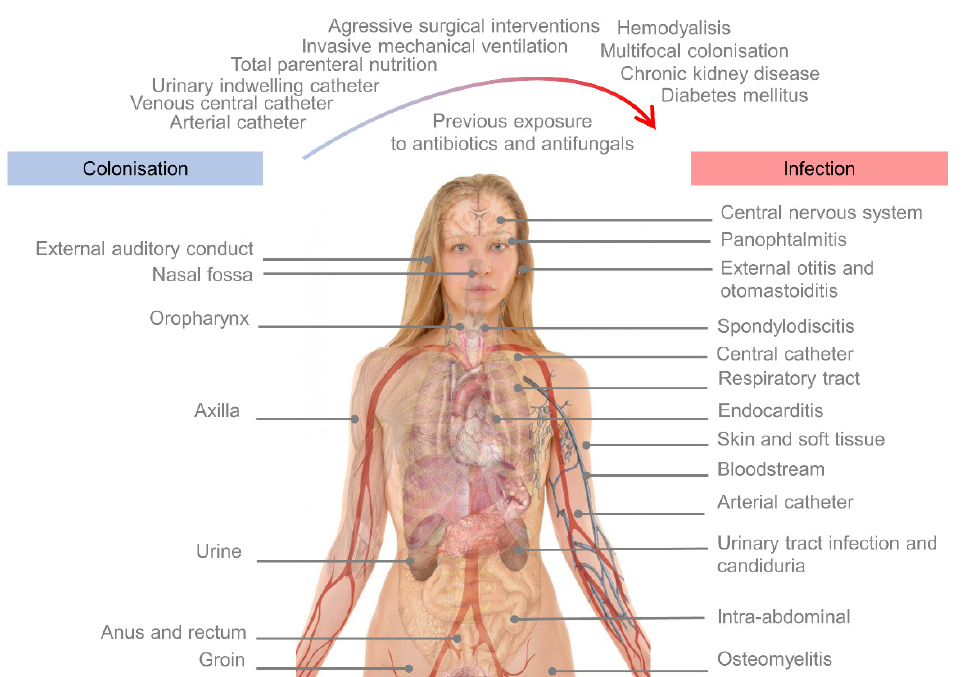
Figure 2. Schema representing the most common colonisation, invasive infection sites, and risk factors for deep-seated infections in patients colonised by C. auris.